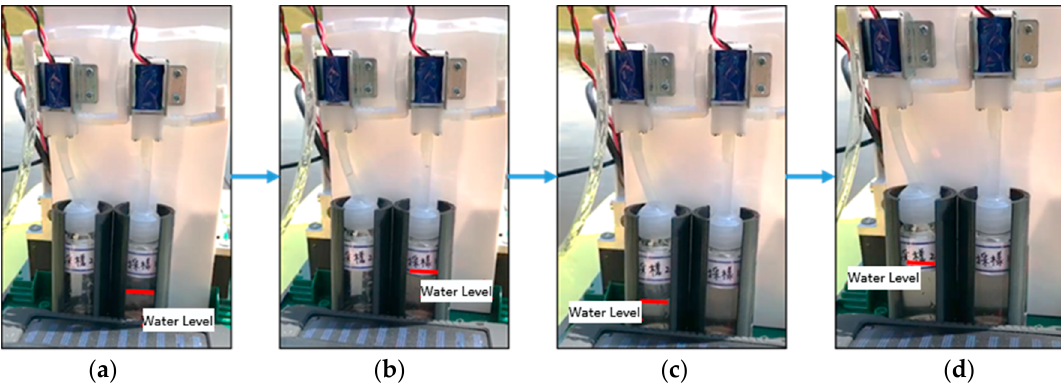
Figure 18. Experimental results for the water quality monitoring task. ( a ) The initial water level of the first sampling bottle. ( b ) The water level of the first sampling bottle after the first water sampling. ( c ) The initial water level of the second sampling bottle. ( d ) The water level of the second sampling bottle after the second water sampling.